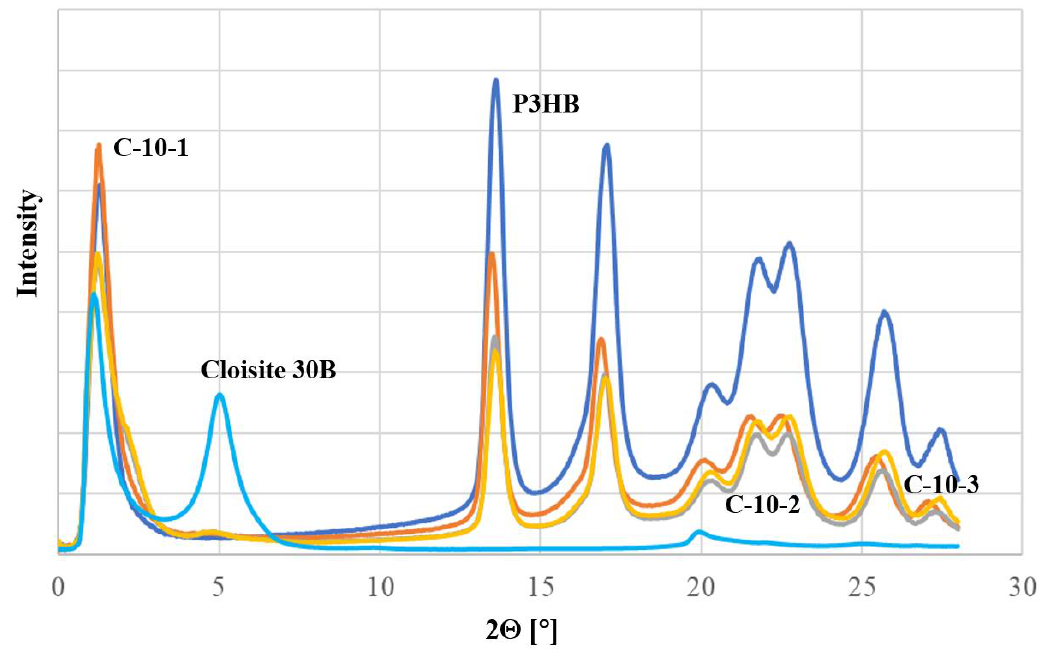
Figure 1. X-ray diffractograms recorded in transmission mode for unfilled P3HB, Cloisite ® 30Borganic nanoclay, and nanobiocomposites containing 10 wt.% of PU400 and 1, 2, and 3 wt.% of Cloisite ®